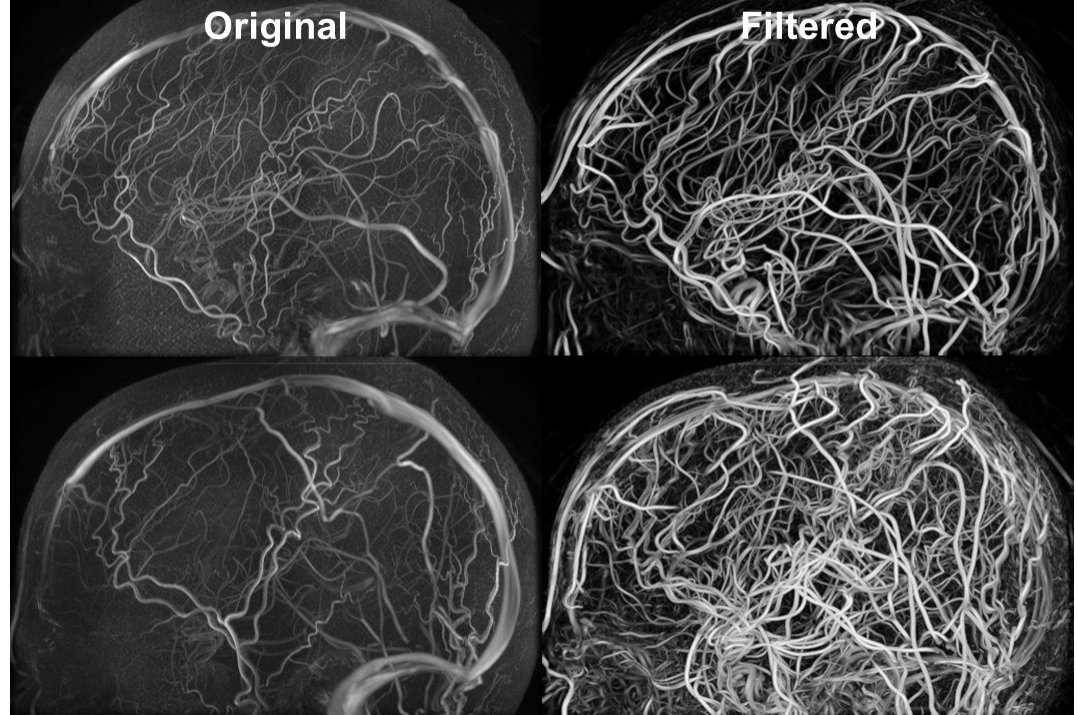
Figure 5. Filtered MRA for vessel segmentation. Hessian-based filters were implemented for suppressing signals from non-vascular tissues and enhancing vascular tissues. The vessel enhancement allows all vessels to exhibit high intensity values and facilitates automatic vessel